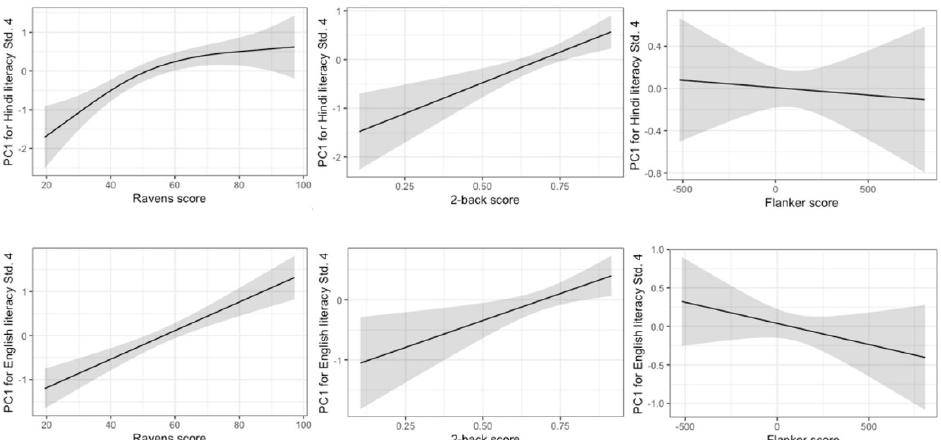
Figure 3. Relations between cognitive abilities and literacy performance in Std. 4 in Hindi and English. Shaded areas indicate 95% confidence interval. Positive relations were found between literacy and Ravens score and literacy and 2-back score in both languages. No significant relations were found between Flanker score and literacy in either of the languages.